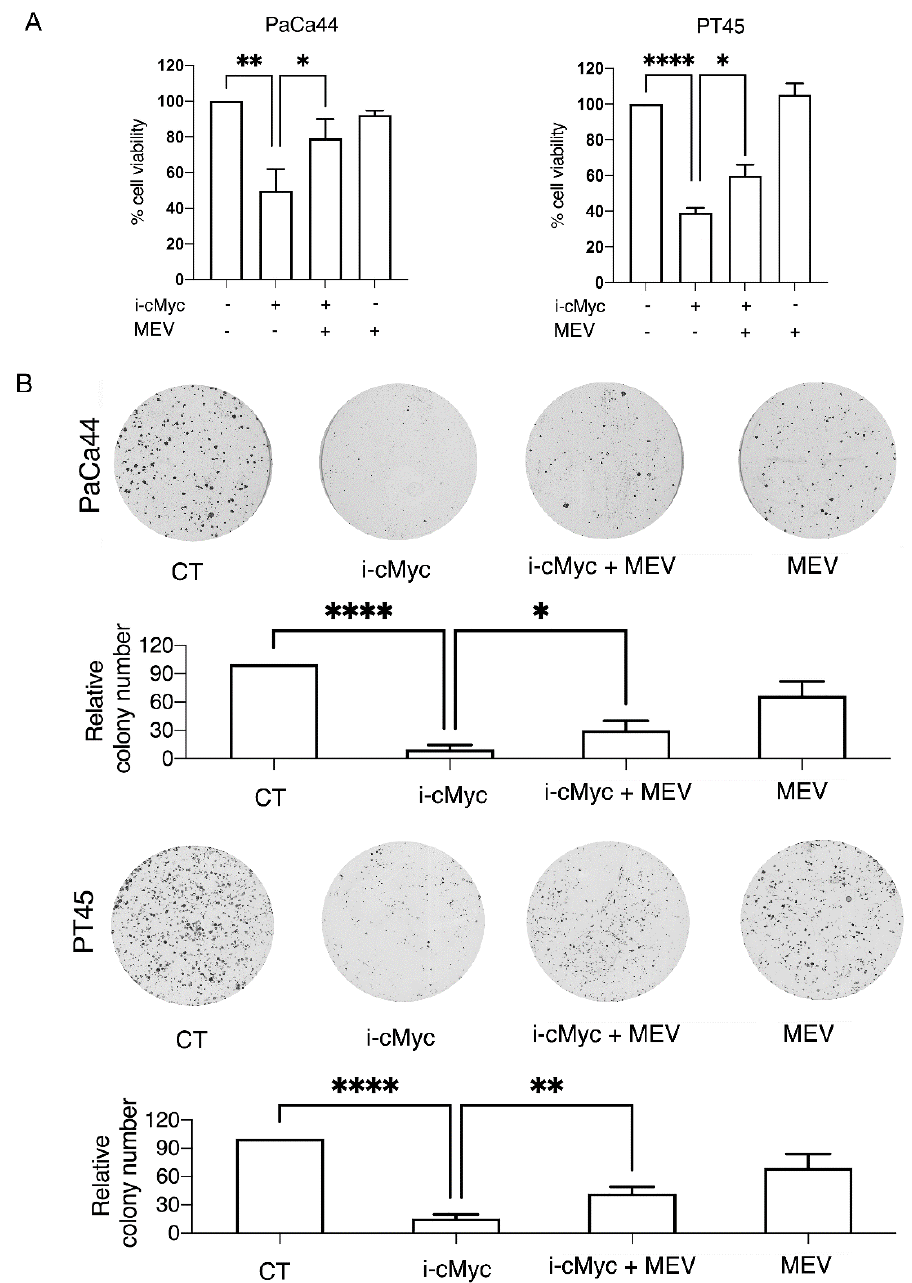
Figure 6. The effects in cell viability and in the colony formation mediated by c-Myc inhibition are counteracted by mevalonate supplementation. PaCa44 and PT45 cells were treated with cMyc inhibitor (i-cMyc) (50 µ M) or MEV (20 µ M) or with both for 48 h to evaluate cell viability and colony formation. ( A ) Cell survival was evaluated by trypan blue exclusion assay. The histograms represent the mean plus SD of live cells as percentage of untreated control cells, p value: * <0.05; ** <0.01; **** <0.0001; ( B ) representative pictures of Paca44 and PT45 colonies stained with crystal violet and histograms of quantitative analyses of colony formation are shown. The numbers of untreated colonies were set to 100. Results are presented as mean ± SD of percent. p value: * <0.05; ** <0.01; **** <0.0001.